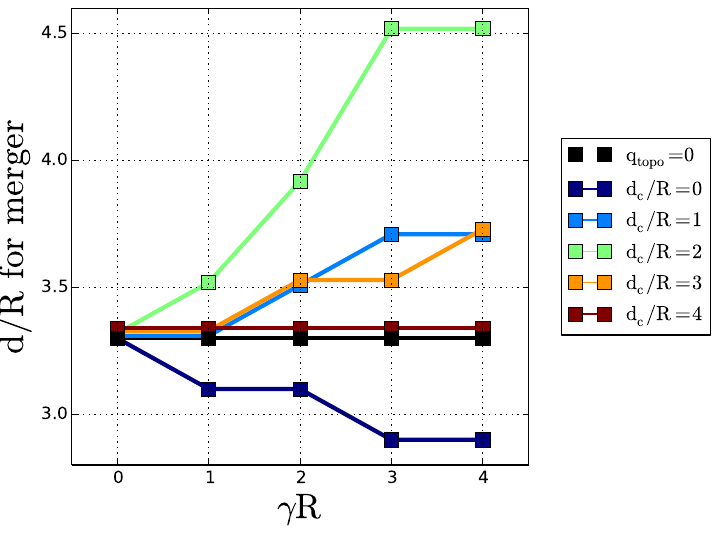
Figure 4. Critical merger distance d ∗ , with respect to stratification, for various distances of the cyclone pair to